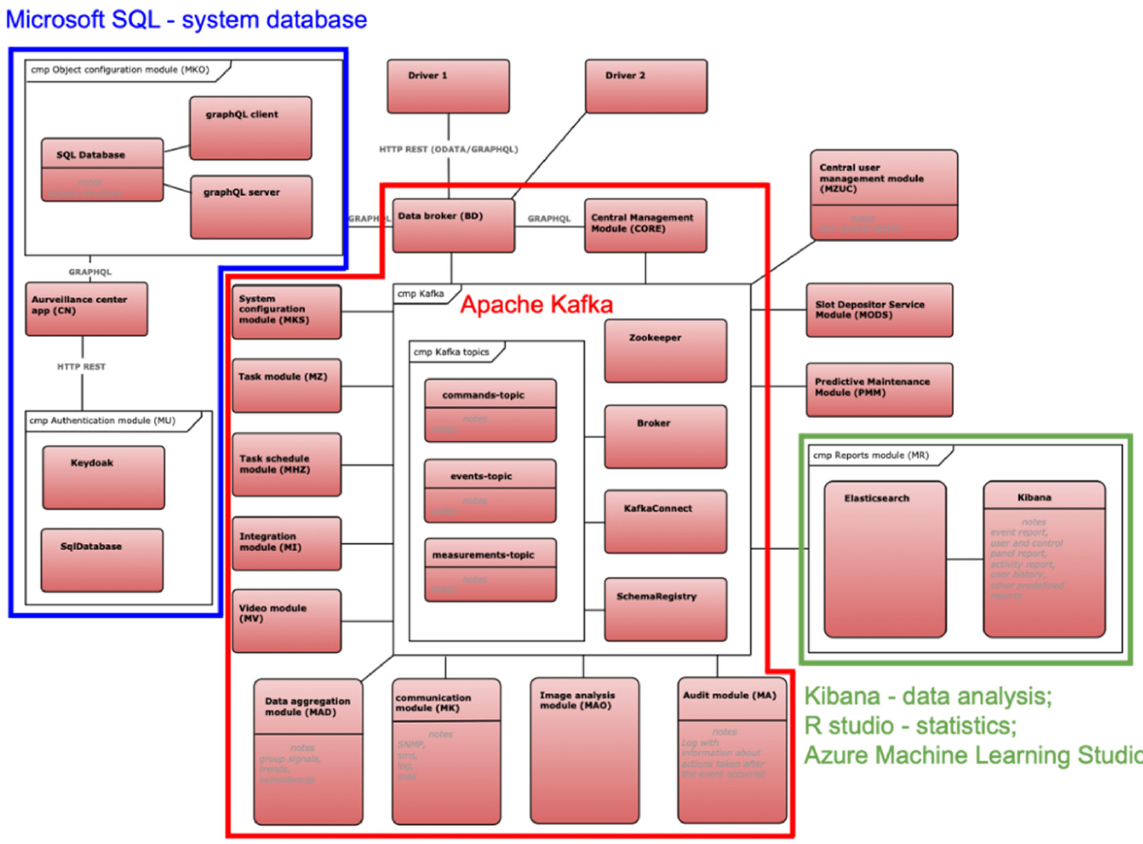
Figure 5. Software architecture of the proposed system.